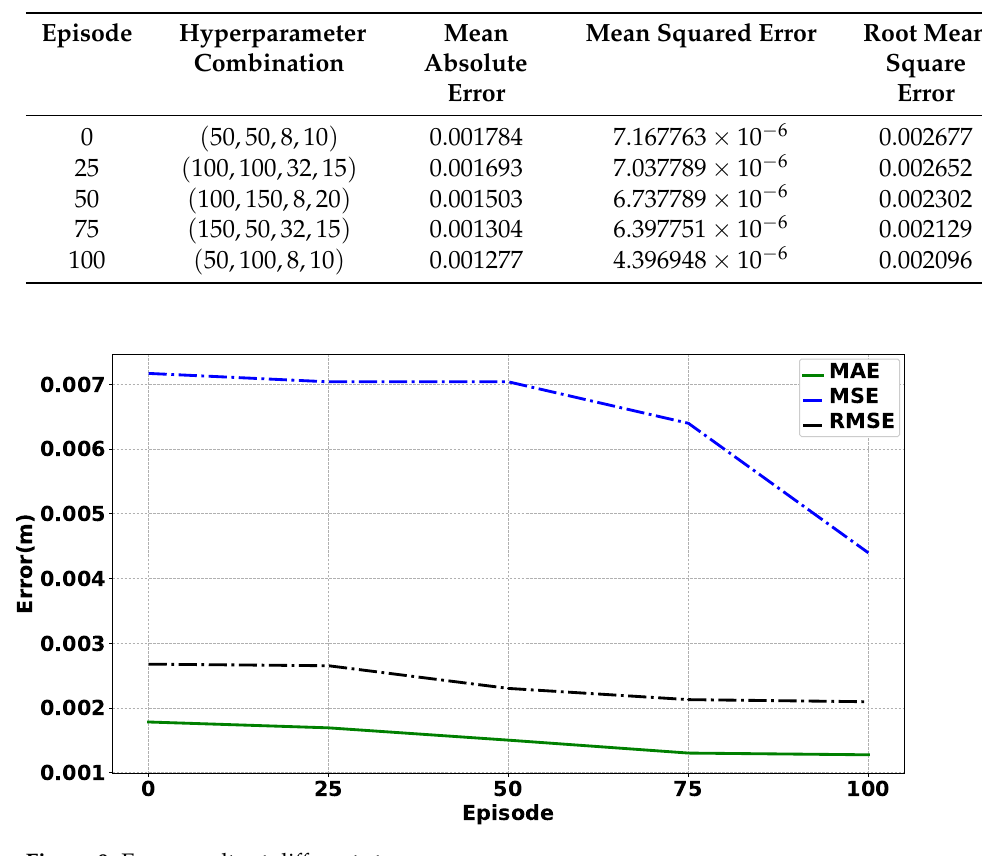
Figure 9. Error results at different